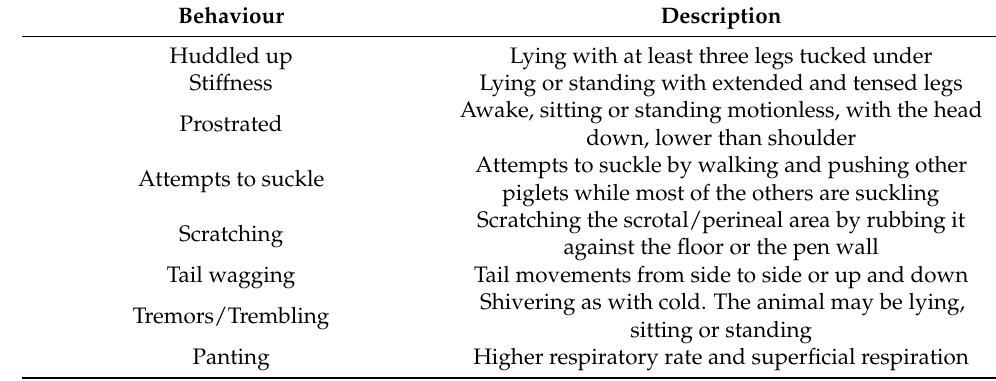
Table 1. Description of variables included in focal assessment of pain-related behaviours.